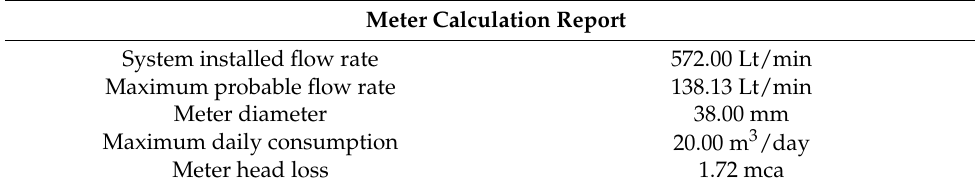
Table 13. General meter calculation report for a commercial building.